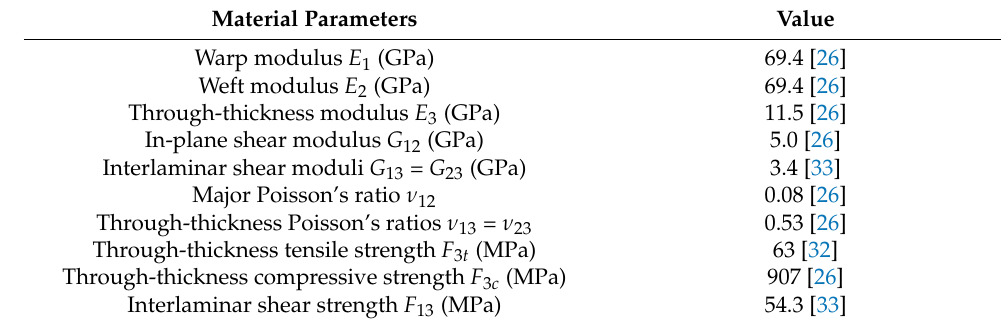
Table 1. Elastic and strength properties of the CFRP.